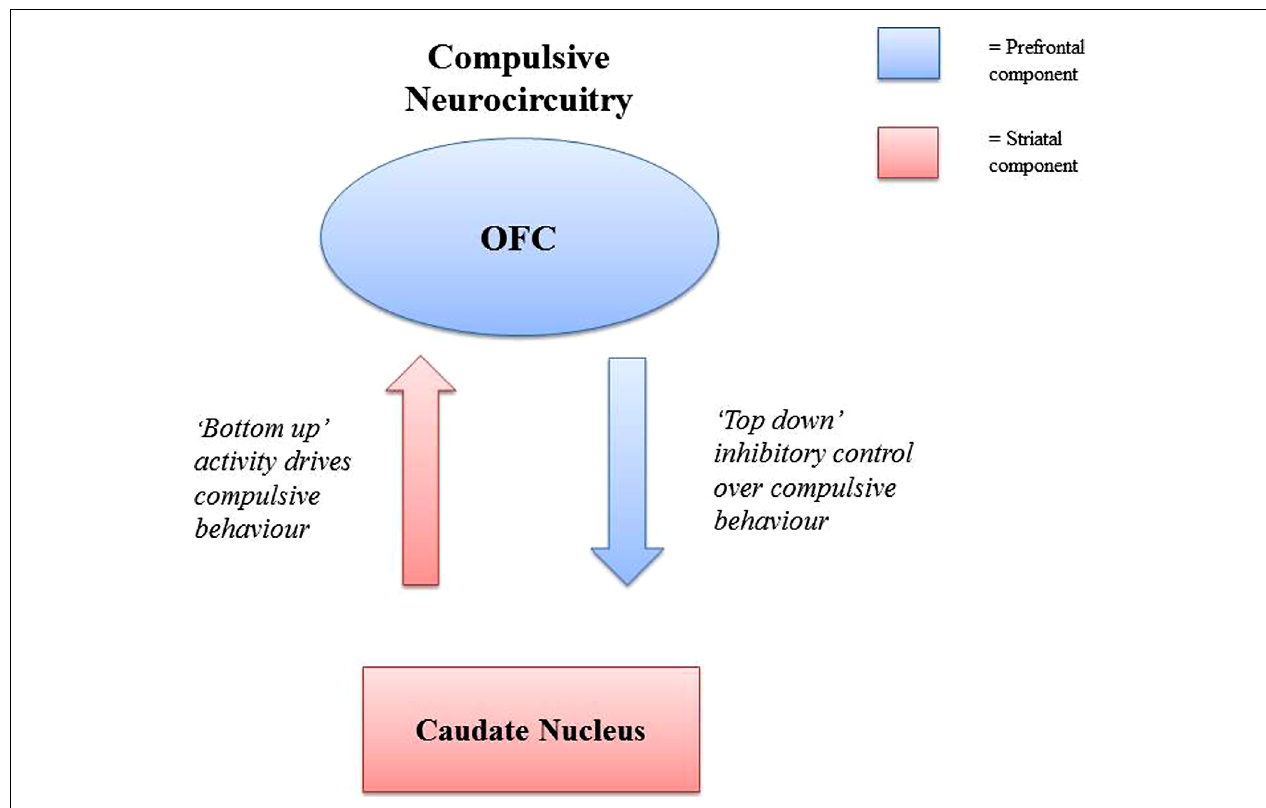
FIGURE 2 | Representation of the cortico-striatal circuitry suggested to be involved in the development compulsive behavior (Robbins, 2007; Brewer and Potenza, 2008; Fineberg etal., 2010). In the circuit, activity in the striatal component drives compulsive behavior, whilst activity in the